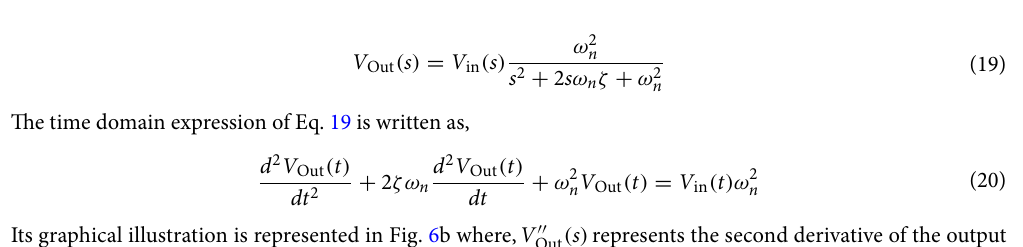
V s ) . At the output, the voltage V s ) appears under in ( out ( =